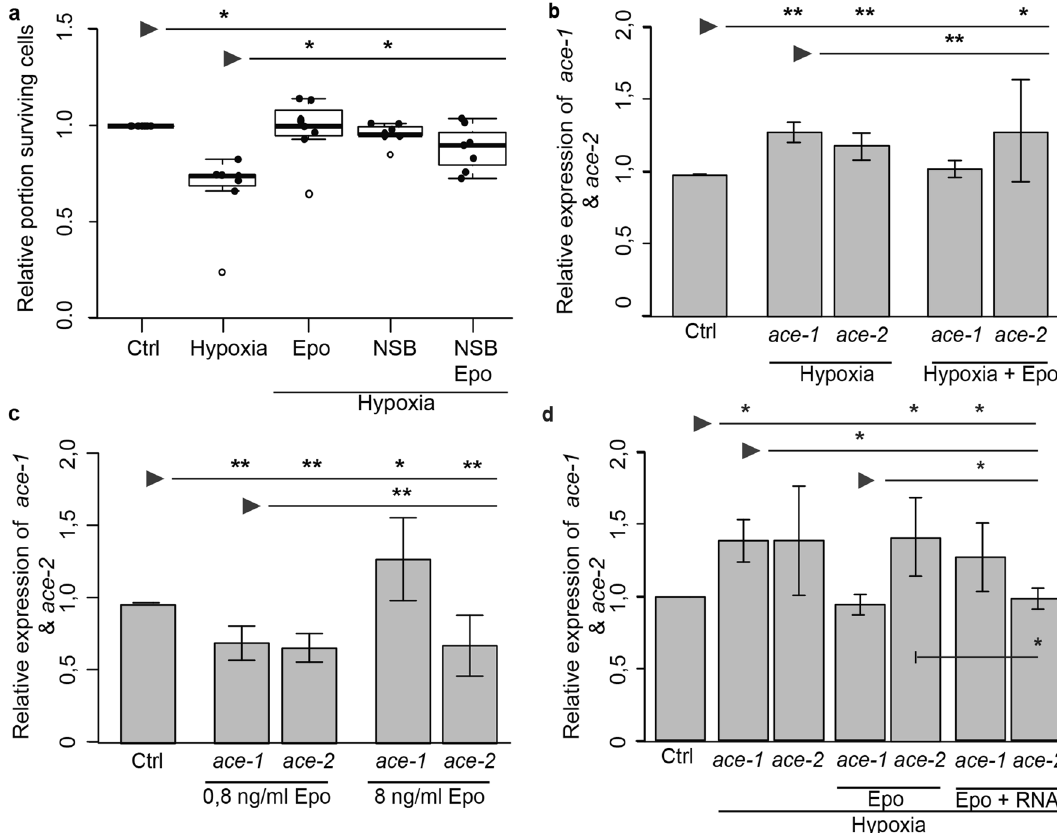
Figure 3. rhEpo-mediated regulation of neuron survival and ace expression in hypoxia-exposed T. castaneum primary neuron cultures. Cultures were exposed to hypoxic conditions (< 0.3% O 2 for 36 h) and treated with 10 µM NSB (entire in vitro period) or/and 0.8 ng/ml rhEpo (starting 12 h before start of hypoxic period). ( a ) Relative survival of primary neurons was normalized to respective untreated normoxic controls (Set to 1). Cells were maintained for 5 days, with two groups receiving NSB (10 µM) over the entire culturing period. Epo (0.8 ng/ml) was added 12 h before hypoxia exposure. Cell survival was analysed via DAPI staining. Hypoxia significantly decreased neuron survival. rhEpo and NSB prevent hypoxia-induced cell death and increase survival to the level of normoxic controls. Combined treatment with rhEpo/NSB increases neuron survival in hypoxia-exposed cultures without reaching significance level. Empty circles depict outliers. n = 7, 112.114 cells analyzed. ( b ) qPCR analysis of Tc-ace-1 and Tc-ace-2 expression in T. castaneum primary neuron cultures. Hypoxia increases expression of both Tc-ace-1 (1.2 ± 0.2 SD) and Tc-ace-2 (1.33 ± 0.3 SD). rhEpo inhibited the hypoxia-induced overexpression of Tc-ace-1 (1.05 ± 0.2 SD) but not of Tc-ace-2 (1.2 ± 0.1 SD). n = 3. ( c ) Primary neuron cultures were depleted of serum on day 3 in vitro and exposed to protective and toxic concentrations of rhEpo for 48 h starting on day 5 in vitro. T. castaneum: 0.8 ng/ml rhEpo (= protective concentration) decrease Tc-ace-1 and Tc-ace-2 transcript levels to 0.71-fold (± 0.1 SD) and 0.69-fold (± 0.1 SD) respectively. 8 ng/m- rhEpo (= toxic concentration) increased Tc-ace-1 transcript levels (1.33-fold ± 0.3 SD) but reduced Tc-ace-2 transcript levels (0.71-fold ± 0.2 SD) in comparison to untreated controls. n = 3. (d ) Epo mediated regulation of ace expression involves CRLF3. T. castaneum primary brain cell cultures were treated with dsRNA targeting CRLF3 for 5 days. Cells were treated with 0.8 ng/ml rhEpo on day 5 and exposed to hypoxia 12 h later for 36 h. Hypoxia significantly increased ace-1 gene expression (1.39 ± 0.15 SD), which was prevented when neurons received Epo before hypoxia (0.95 ± 0.07 SD). RNAi-mediated knock down of CRLF3 expression prevented Epo-mediated reduction of ace-1 transcript levels in hypoxia-exposed cultures without significant difference to hypoxia-only exposed cultures (1.28 ± 0.24 SD compared with 1.39 ± 0.15 SD). Ace-2 expression levels were elevated in hypoxia, which was not prevented by rhEpo. Knockdown of CRLF3 expression reduced ace-2 transcript levels of hypoxia/Epo-exposed neurons to the level of normoxic controls. n = 3. For ( b–d ) Expression of each ace transcript was compared and normalized to expression within the respective control group. Statistics with pairwise permutation test and Benjamini–Hochberg correction. Significant differences are indicated by asterisks (*p < 0.05; **p <